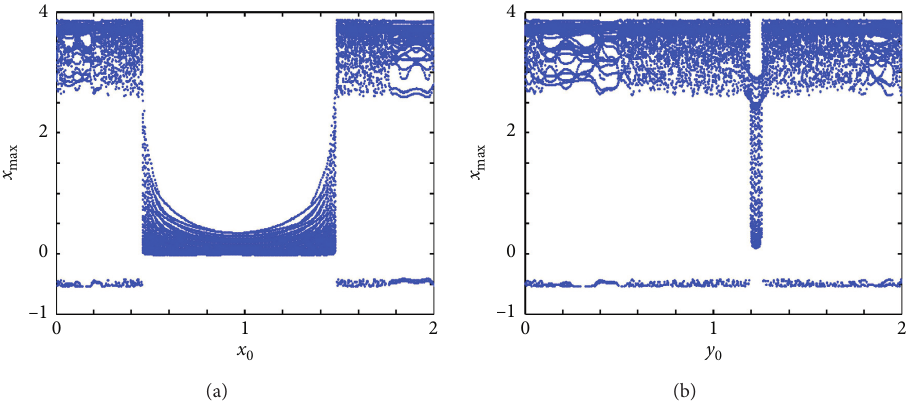
Figure 6: Bifurcation diagram of the fractional-order centrifugal flywheel governor system: (a) x